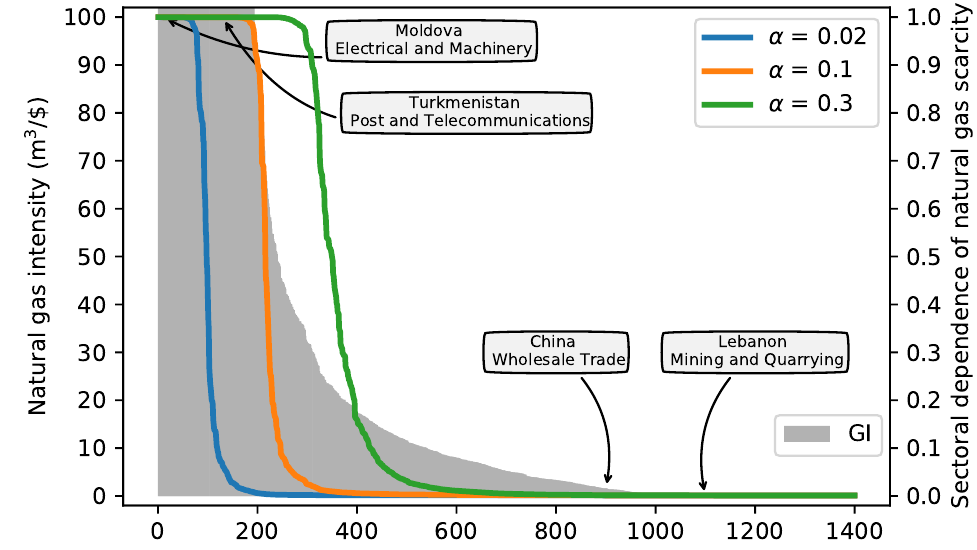
Figure 2. Sectoral natural gas intensity and the corresponding natural gas dependence sorted with decreasing